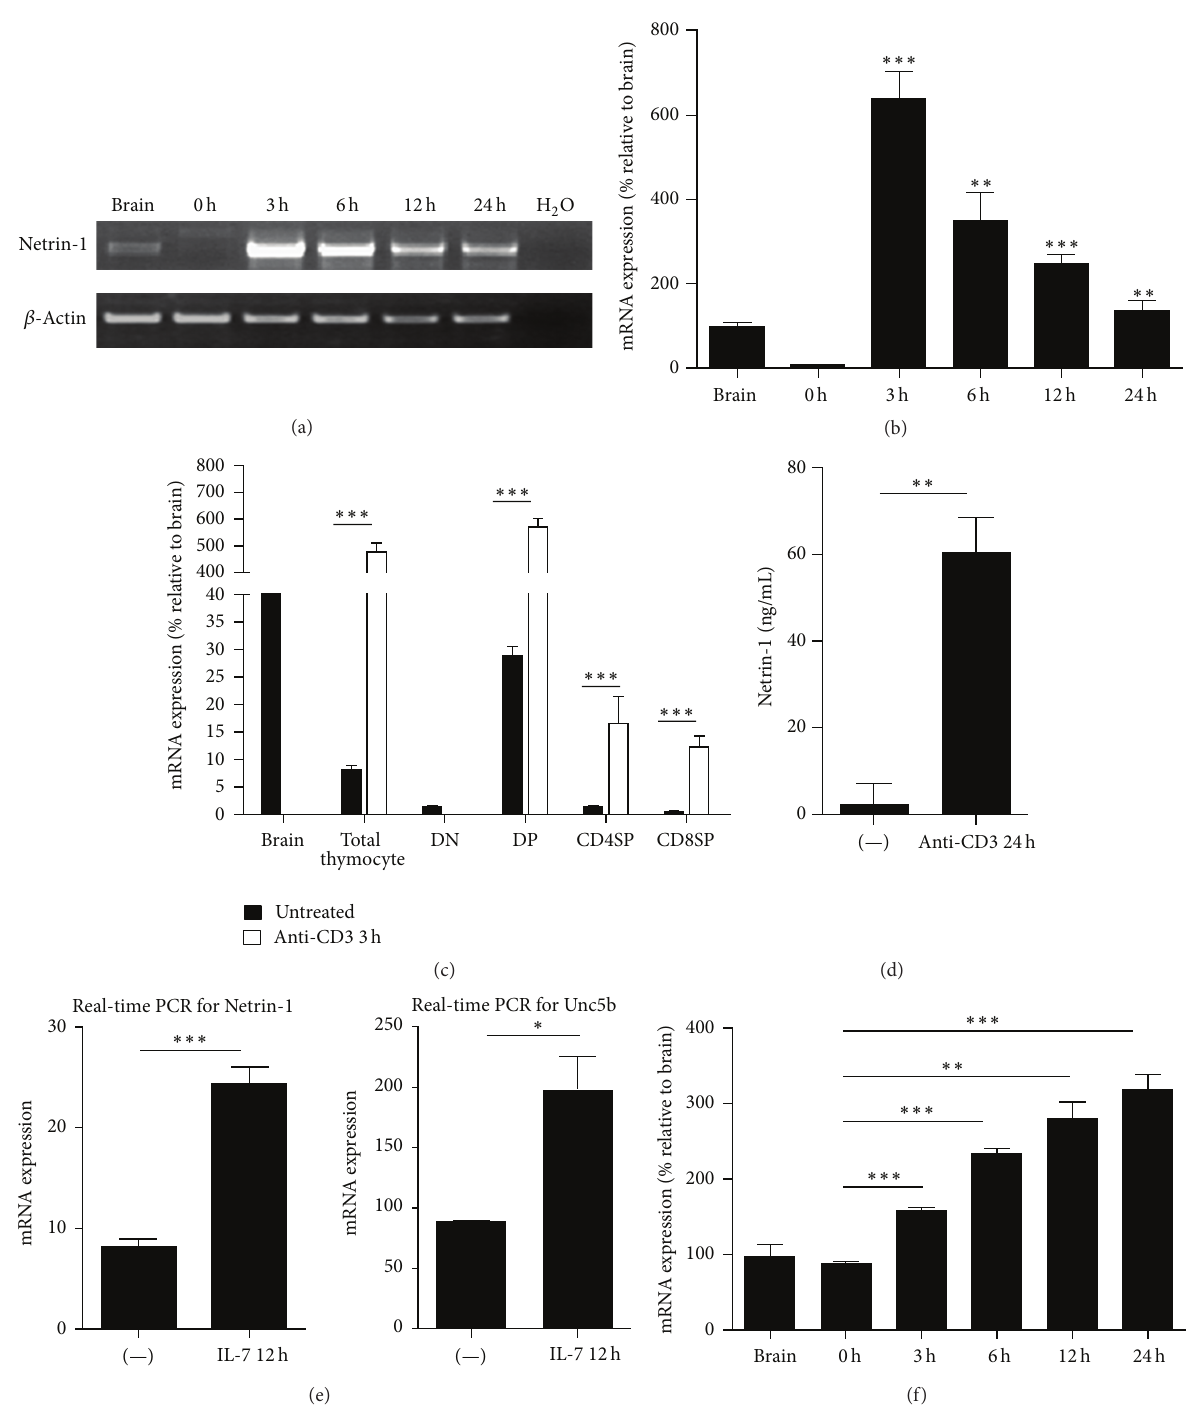
Figure 2: Anti-CD3 and IL-7 stimulation upregulates Netrin-1 and Unc5b expression on thymocytes. ((a) and (b)) RT-PCR showing an increase in Netrin-1 gene expression on thymocytes following anti-CD3 stimulation. Histograms represent the Netrin-1/actin ratio. (c) Real- timePCRshowingNetrin-1expressiononthymocytesubsets,DN,DP,CD4SP,andCD8SPbeforeandafteranti-CD3stimulation.(d)Enzyme- linked immunosorbent assay of Netrin-1 in conditioned medium treated with anti-CD3 (5 𝜇 g/mL). (e) Real-time PCR showing Netrin-1 and Unc5b expression by IL-7-treated (12 h) or untreated total thymocytes. (f) Real-time PCR showing an increase in Unc5b gene expression on thymocytes following anti-CD3 stimulation. Data shown in each image are representative of three independent experiments. NS: not significant; ∗ 𝑃 < 0.05 ; ∗∗ 𝑃 < 0.01 ; ∗∗∗ 𝑃 < 0.001